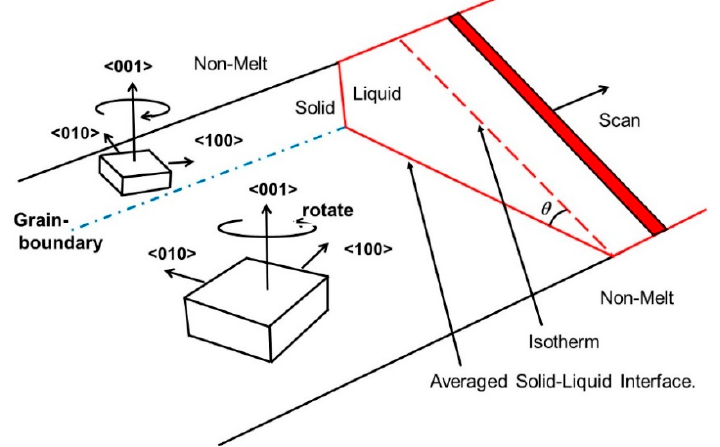
Figure 16. Crystal growth at the low laser power but deviated from the lateral growth threshold power. After Sasaki et al. [53].